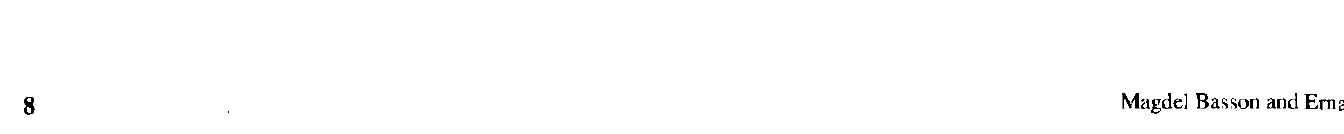
Table 3. A comparison between the experimental and control groups' post-test results Symbol English phrase number